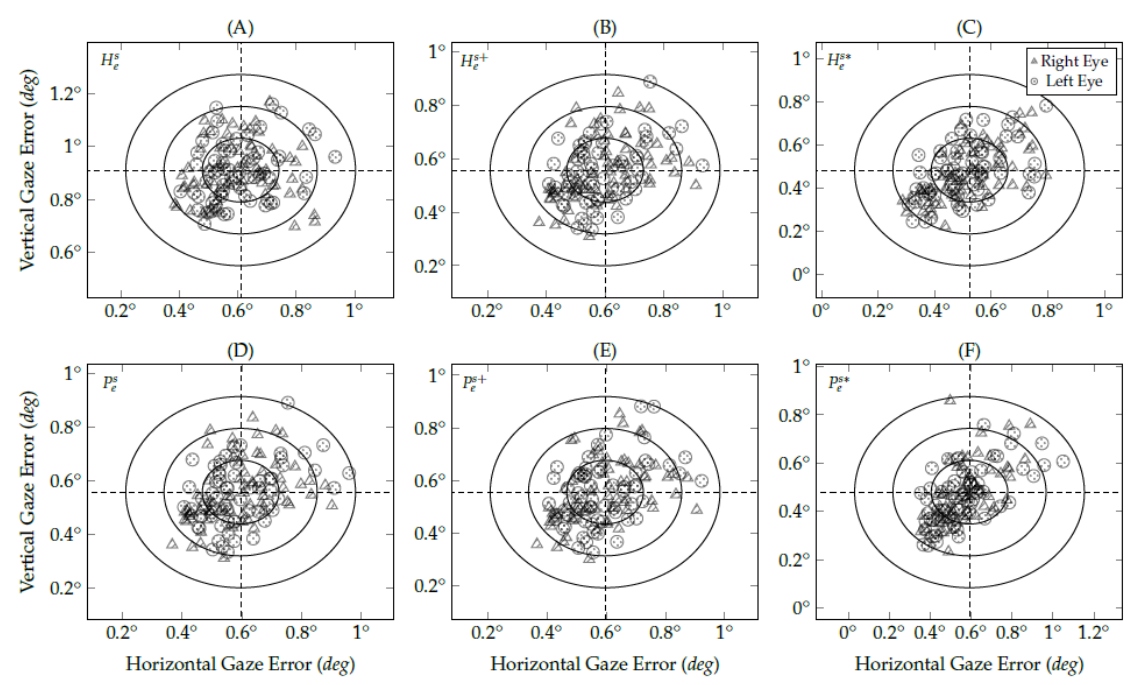
Figure 14. An overview of user study results considering two distinct classes, the gaze estimation from the left and right eye. The three circles in each scatter plot represent the 68–95–99.7 rule of a normal distribution. This figure shows the gaze estimations from ( A ) a traditional homography gaze estimation method; ( B ) a homography gaze estimation method with the eye-camera location compensation; ( C ) a homography gaze estimation method with both camera location and distortion compensations; ( D ) a traditional second-order polynomial gaze estimation method; ( E ) a polynomial gaze estimation method with the eye-camera location compensation; ( F ) a polynomial gaze estimation method with both camera location and distortion